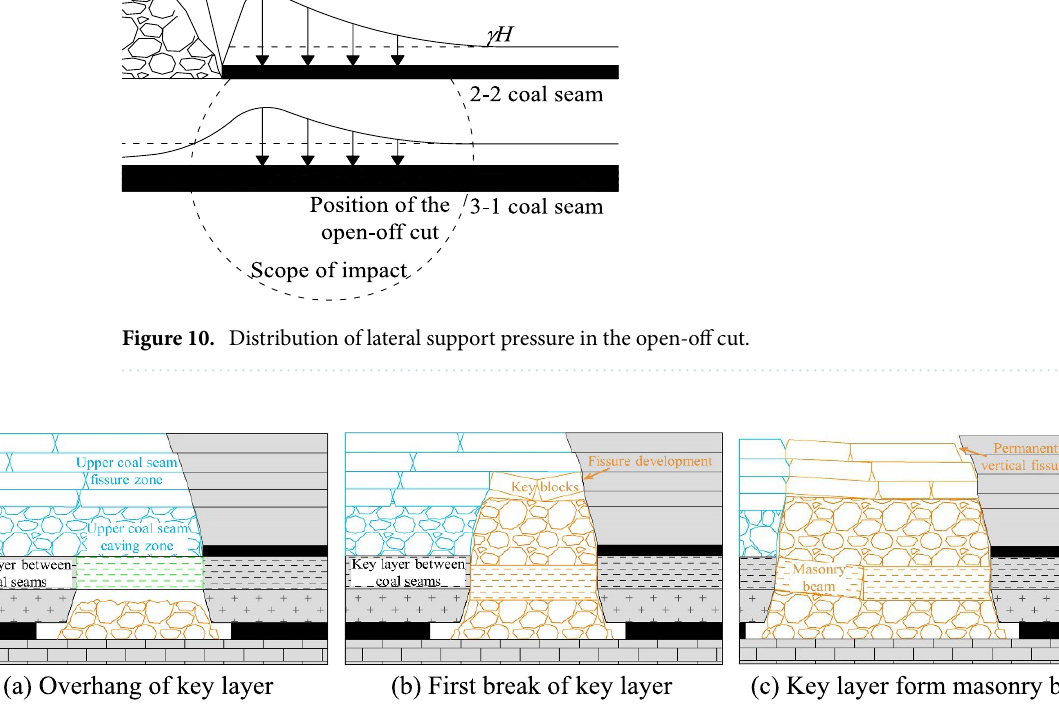
Figure 11. Overlying structures mined in close coal seams.